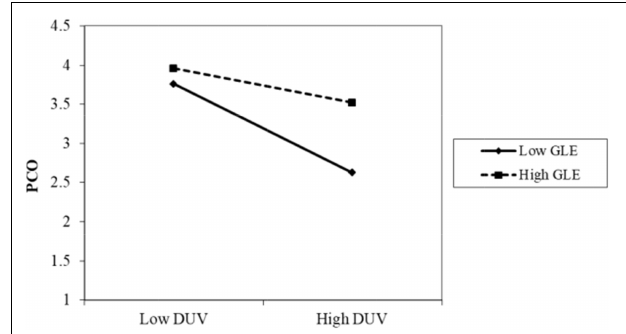
FIGURE 5 | Moderating effect of GLE. GLE, government legislation; DUV, data vulnerability; PCO, psychological